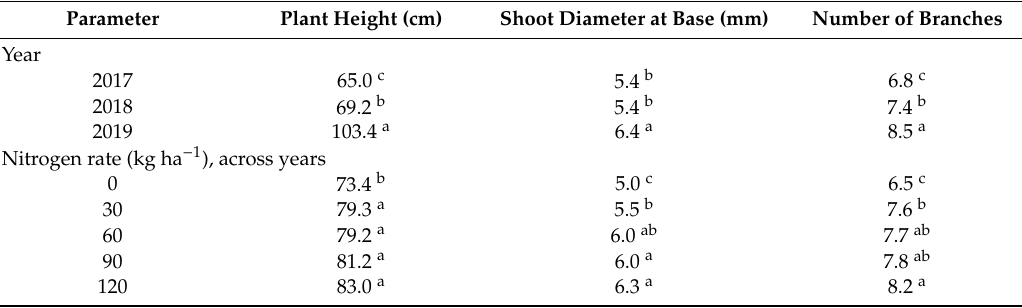
Table 3. Selected morphometric properties of crambe